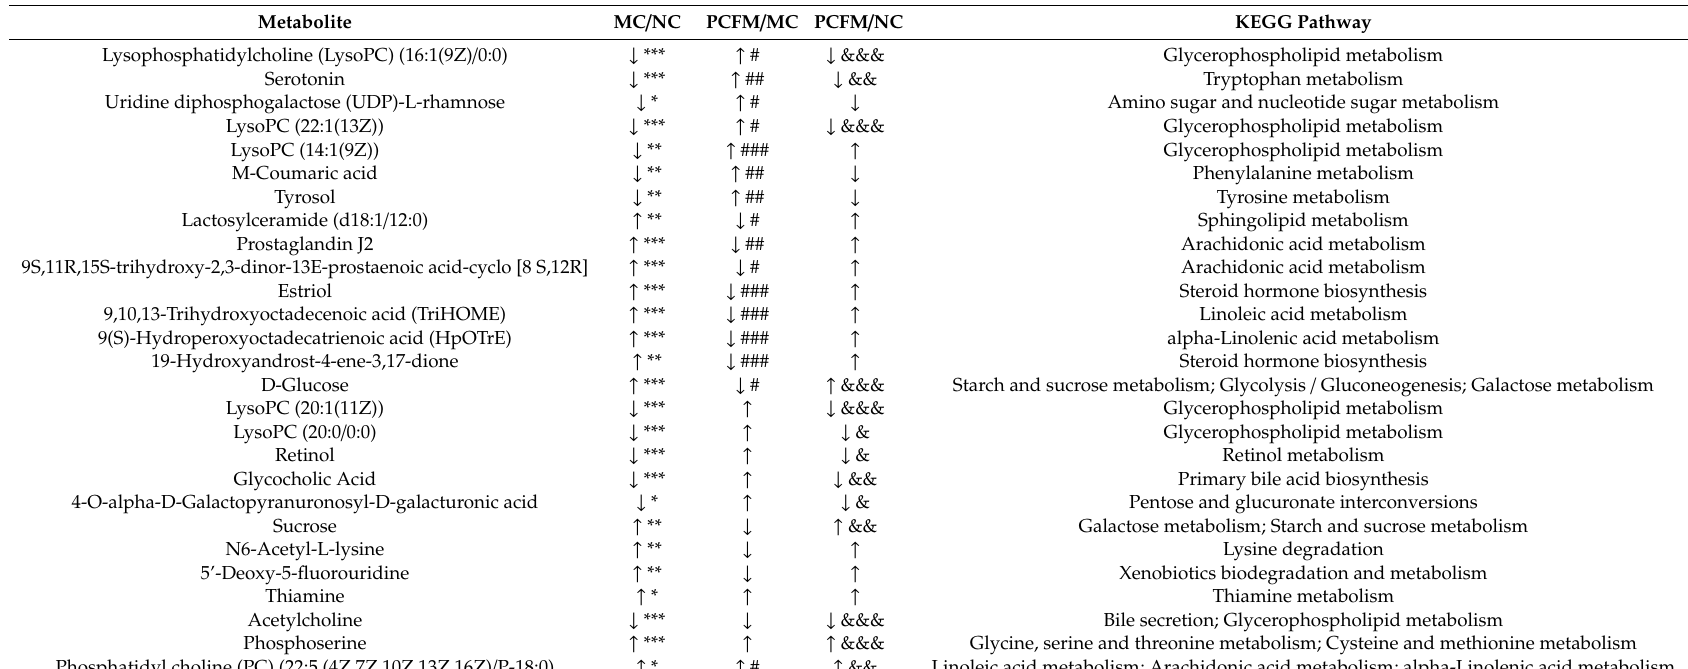
Table 1. The metabolites that were involved in KEGG